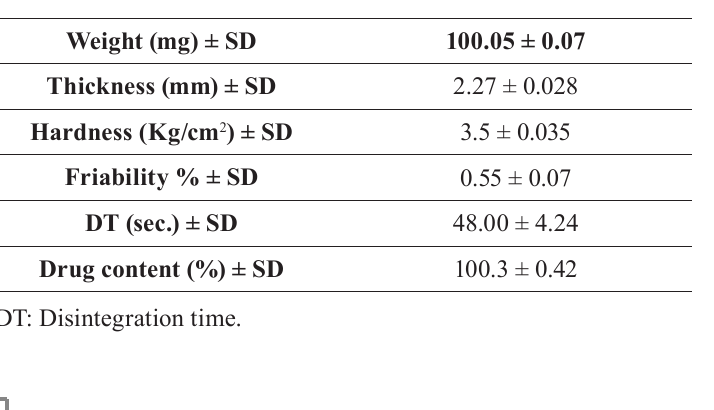
TABLE II - Post Compression physical parameters of core tablets